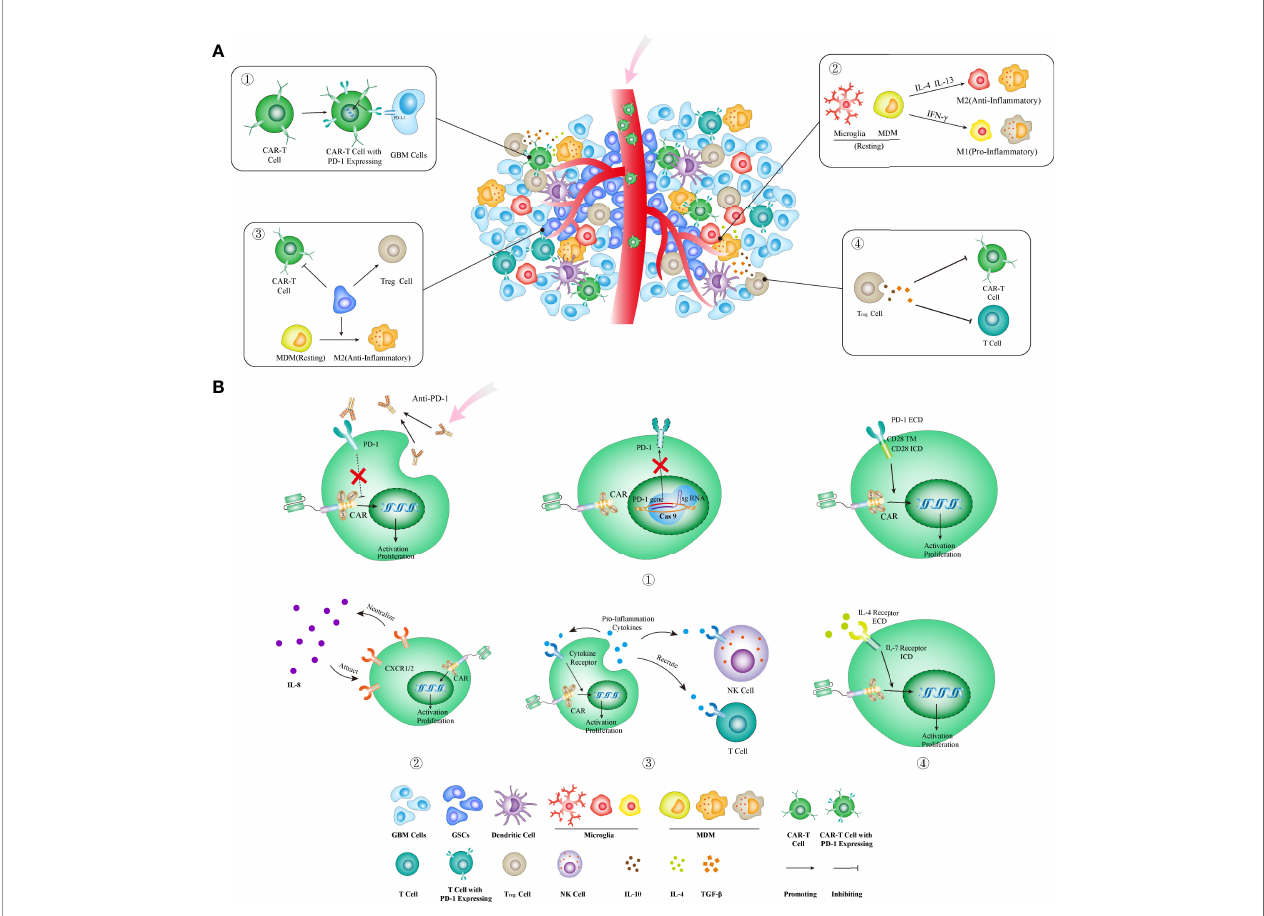
FIGURE 3 | Strategies to overcome the highly immunosuppressive GBM microenvironment. (A) The immunosuppressive microenvironment can limit CAR-T cell functions through several ways: ① upregulating PD-1 and other immune checkpoint molecules; ② increasing IL-4 and IL-13 that promote the transformation of TAMs into anti-in fl ammatory phenotype; ③ existence of GSCs that directly and indirectly (through activating Treg cells and M2-type TAMs) inhibit CAR-T cell functions; ④ increasing the in fi ltration of Treg cells that directly and indirectly (through secreting IL-10, TGF- b , etc.) suppresses CAR-T cell functions. (B) The corresponding strategies in CAR designs to block or reverse these immunoinhibitory effects. ① Three methods for blocking the PD-1 pathway: combining with antibodies blocking the PD-1 molecule (left), knocking out the PDCD1 gene (encoding PD-1) by the genome editing method (middle), and using a PD-1 chimeric switch receptor (right) that reverses the inhibitory signal by PD-1 activation into the stimulatory signal within CAR-T cells; ② CAR-T cells armed with IL-8 receptor (CXCR1 and CXCR2) could be attracted into tumors enriched with IL-8 and neutralized its immune-inhibitory effect; ③ the fourth-generation CAR-T cells armed to secrete proin fl ammatory cytokines that can enhance the direct tumor-killing activities by CAR-T cells as well as the indirect bystander killing by endogenous T cells; ④ inverting the inhibitory effects of anti-in fl ammatory cytokines through transgenic expression of an inverted cytokine receptor that fuses the IL-4 receptor exodomain with the IL-7 receptor endodomain that activates T cells. MDM, myeloid-derived macrophages; ECD, extracellular domain; TM, transmembrane domain; ICD, intracellular domain; GSC, glioma stem